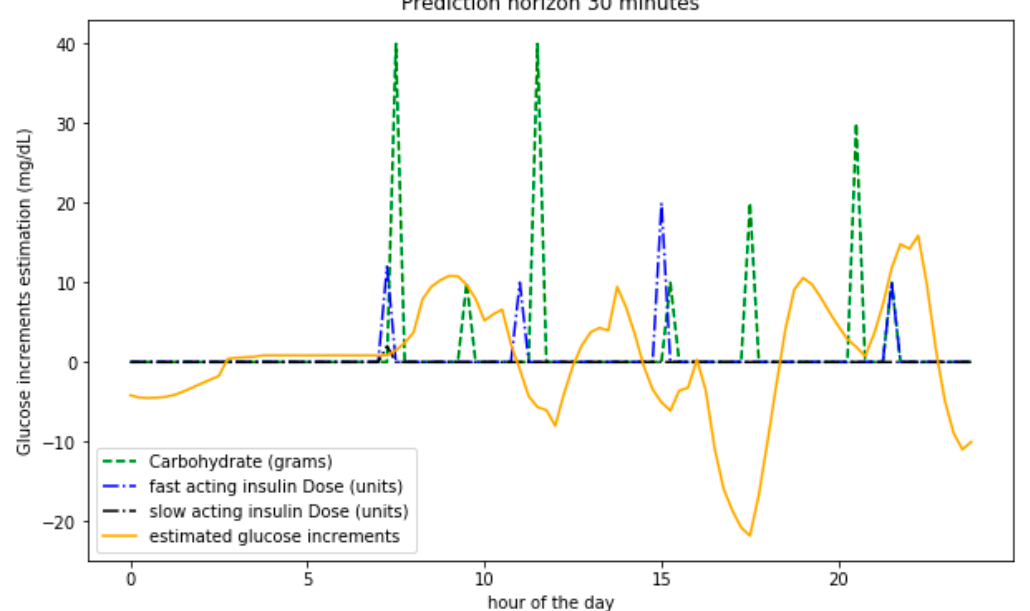
Figure 6. Predictions for BG variations on a 30 min horizon for a single day for a participant based on insulin and meals.